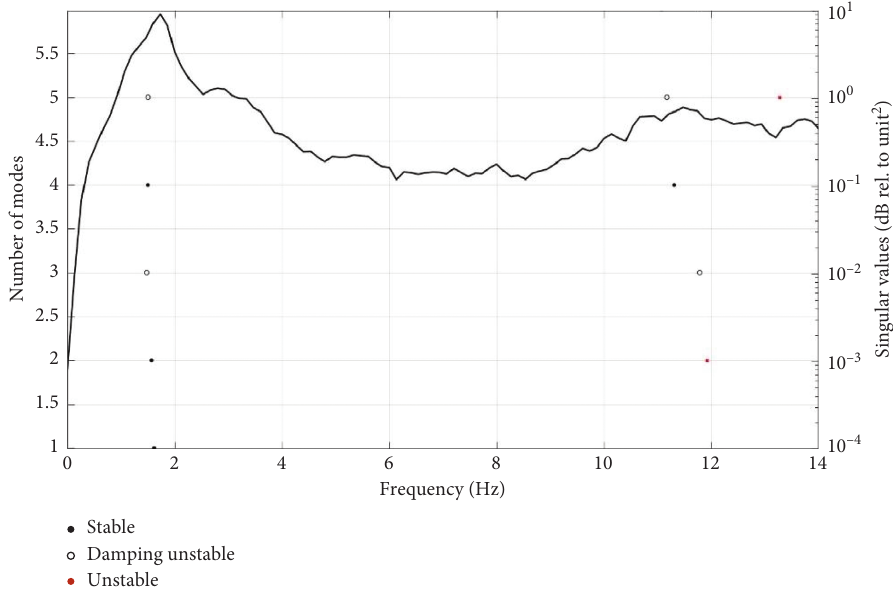
Figure 11: The stabilization diagram for Hyundai Elantra 2011.